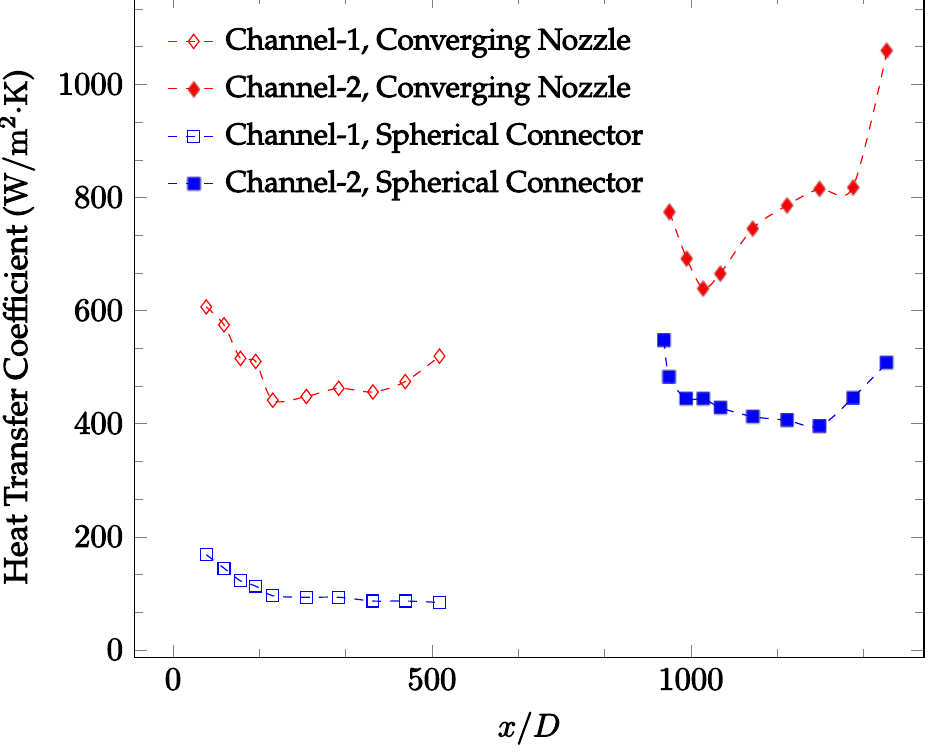
Figure 16. Change in convective heat transfer coefficient of deionized water as a function of dimen- sionless distance for a Reynolds number of 100. Converging and spherical connectors are used.